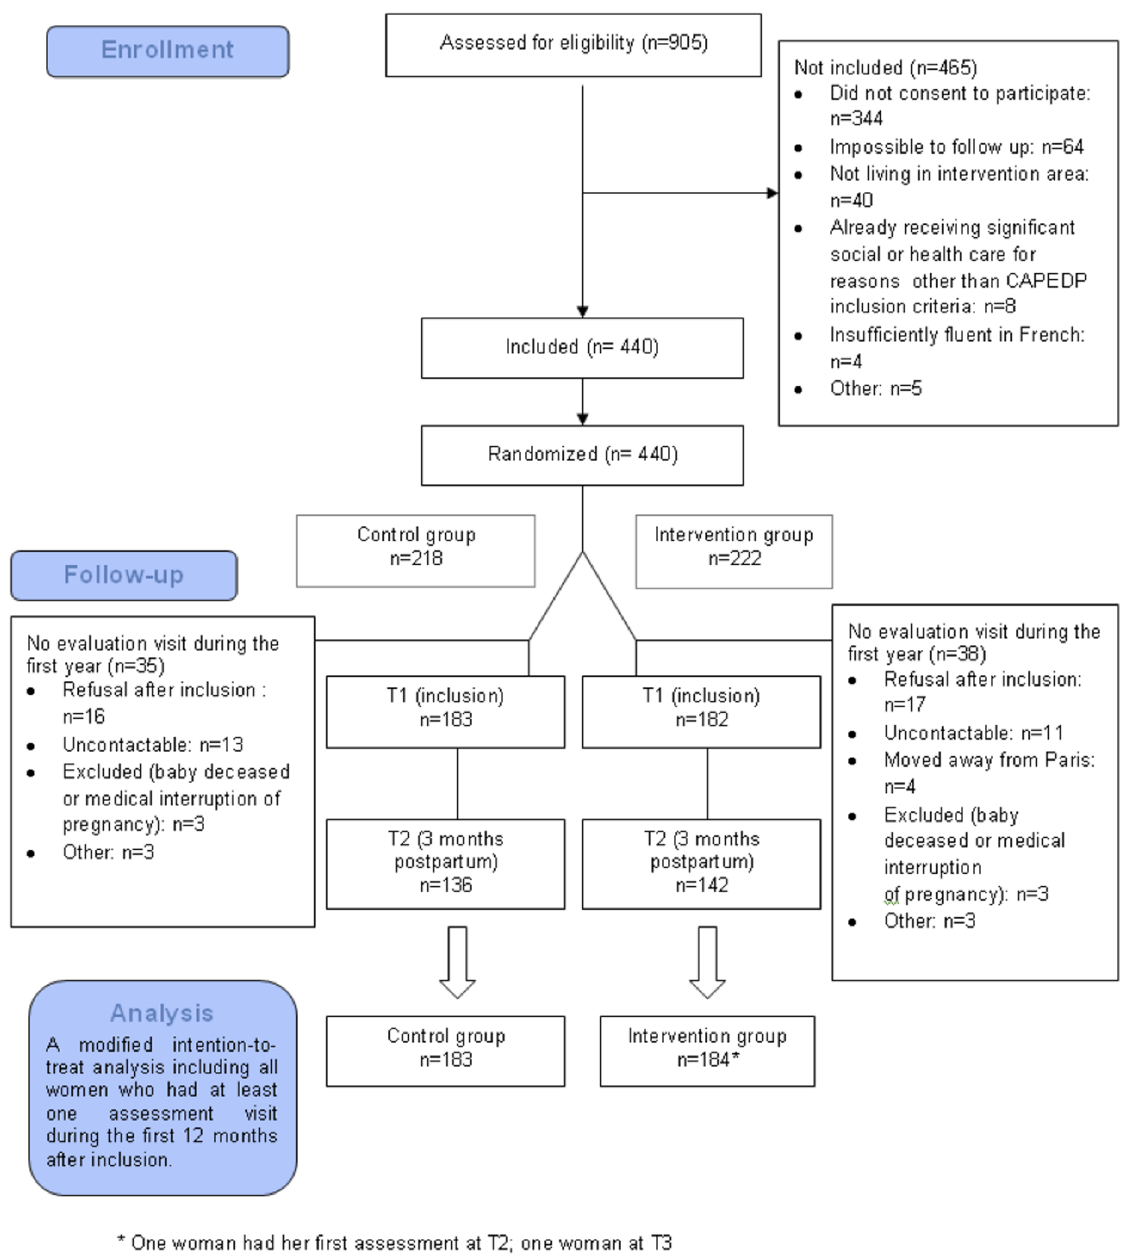
Figure 1. CAPEDP Flowchart Diagram.